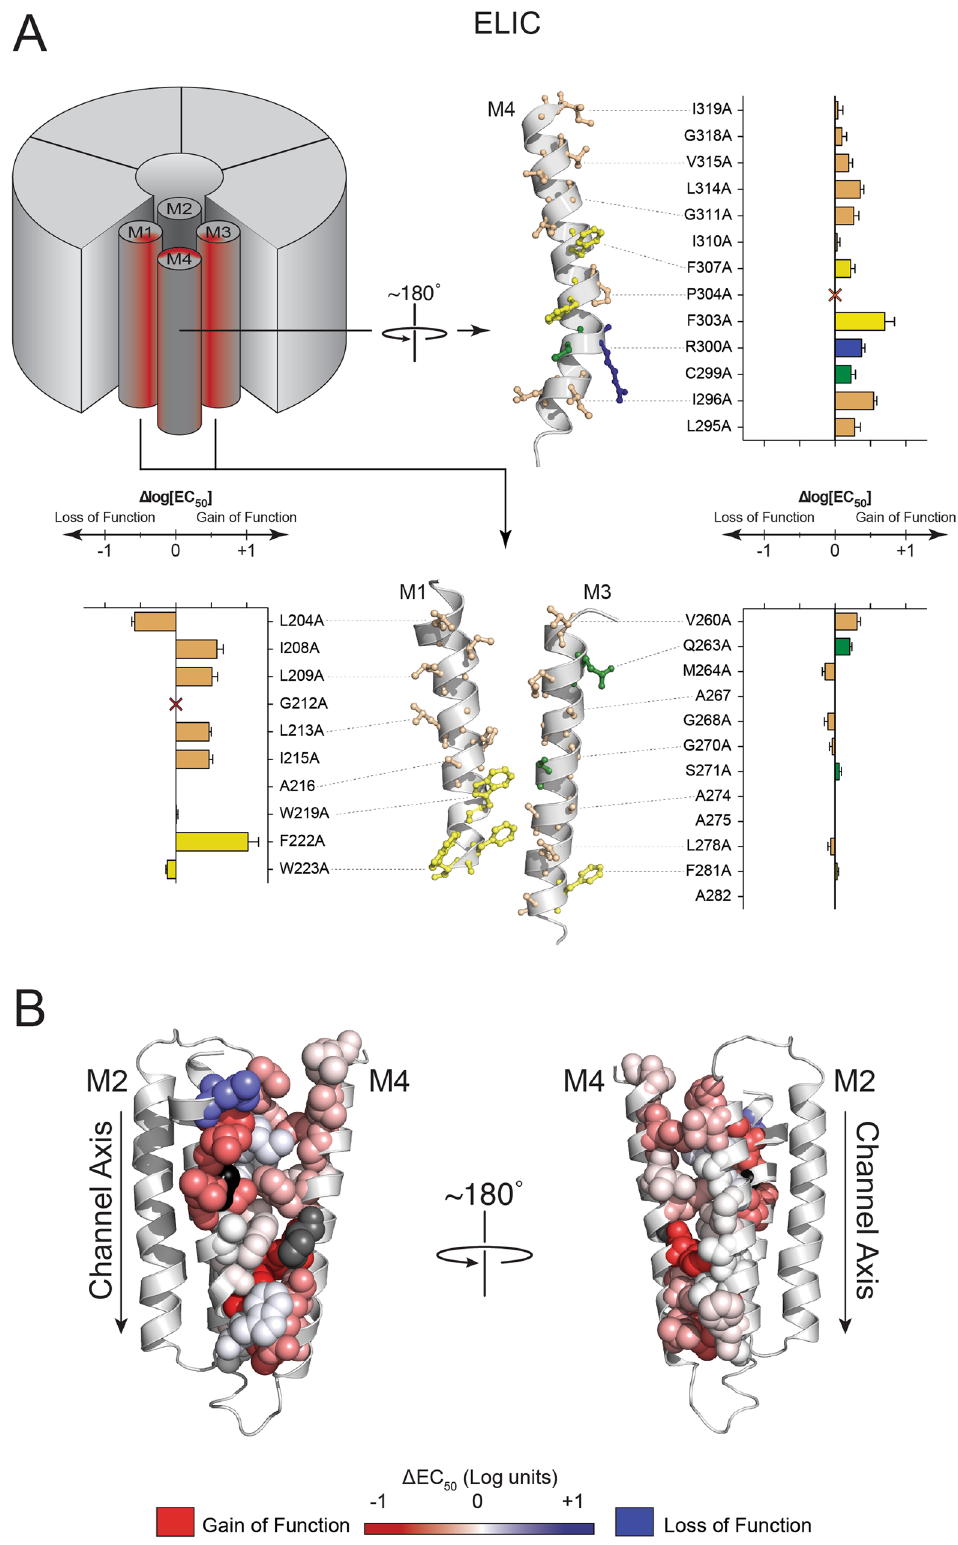
Figure 4. Functional effects of Ala mutations at the M4-M1/M3 interface in ELIC. ( A) Changes in the − log(EC 50 ) resulting from Ala mutations of residues on M4 (top right panel), M1 (bottom left) and M3 (bottom right). Residues and bar graphs are colour-coded as in Fig. 3. The bar graphs represent the magnitude of change ± the standard deviation. ( B) Changes in the − log(EC 50 ) values are heat-mapped onto an ELIC homology model (based on GLIC structure). The magnitude of the shift in pH 50 is depicted via colour intensity, as in Fig. 3. P304A mutant is coloured grey, due to altered desensitization